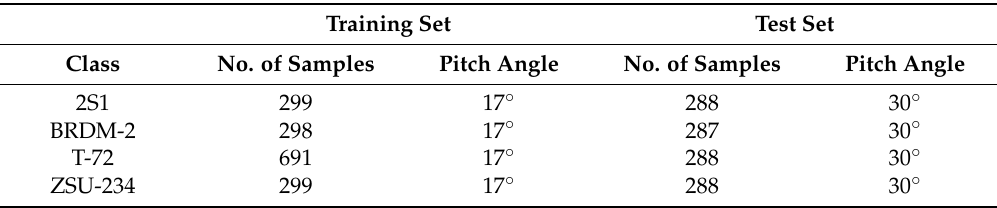
Table 3. Description of training and test sets under EOC1.